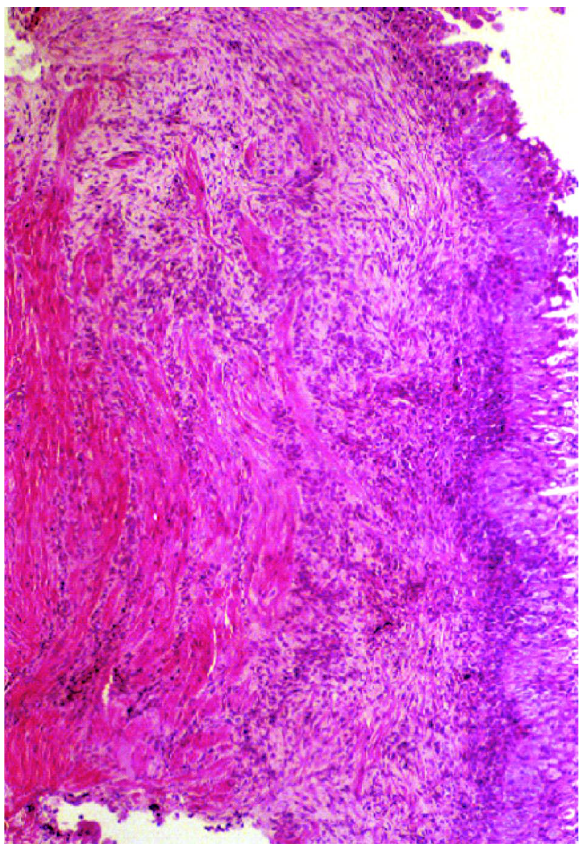
Figure 9 – Histological slide showing growth of stratified epi- thelium and preservation of musculature